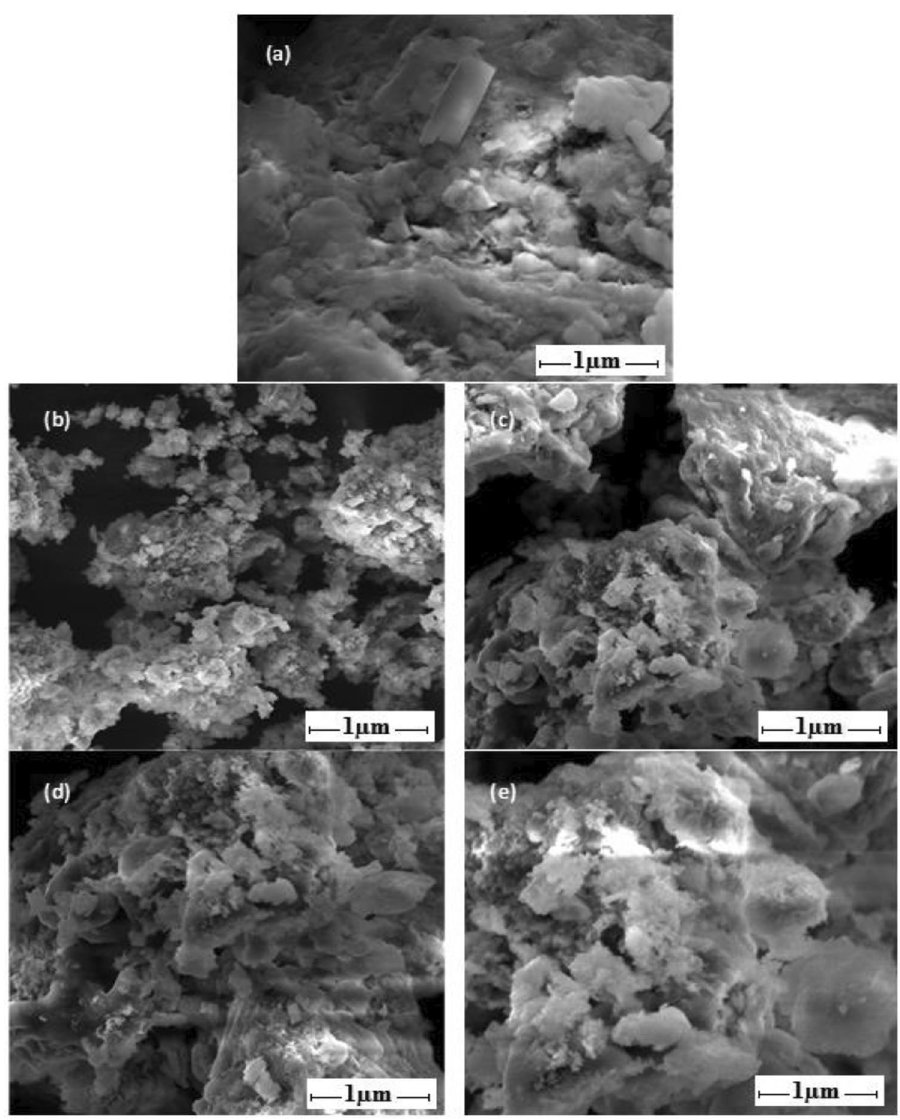
Figure 3. SEM images showing ( a ) unmodified bentonite, and ( b )–( e ) modified bentonite (B-BTC, B-BTB, B-DSS and B-BEHA).